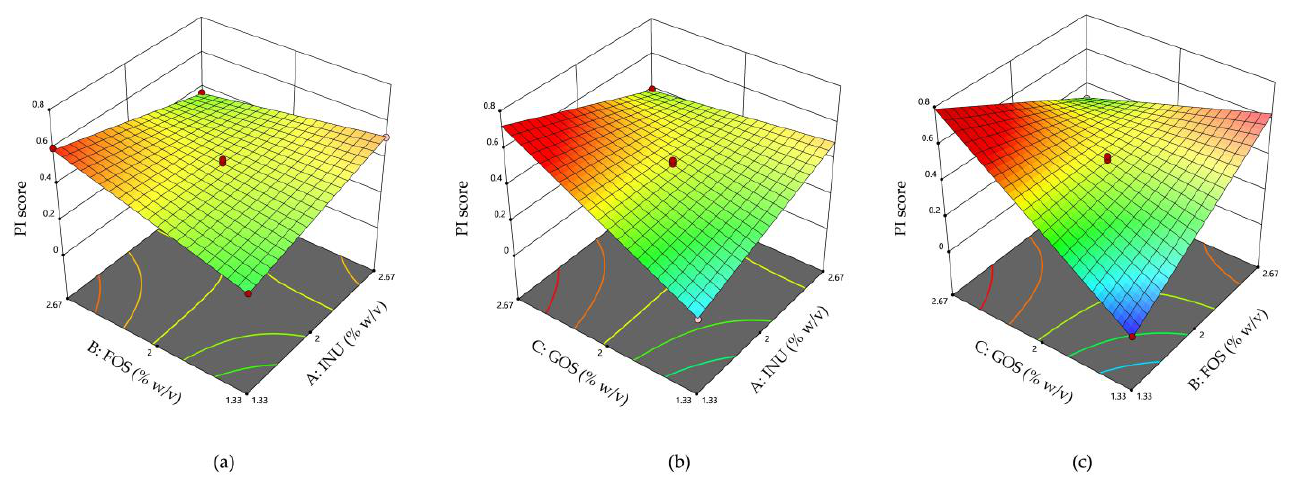
Figure 6. Response surface plots of the PI score for the interactions between the independent factors: ( a ) effect of INU and FOS; ( b ) effect of INU and GOS; and ( c ) effect of FOS and GOS. Table 4. Analysis of variance (ANOVA) for the quadratic model of the total SCFAs with a Box– Behnken design (BBD) experiment.